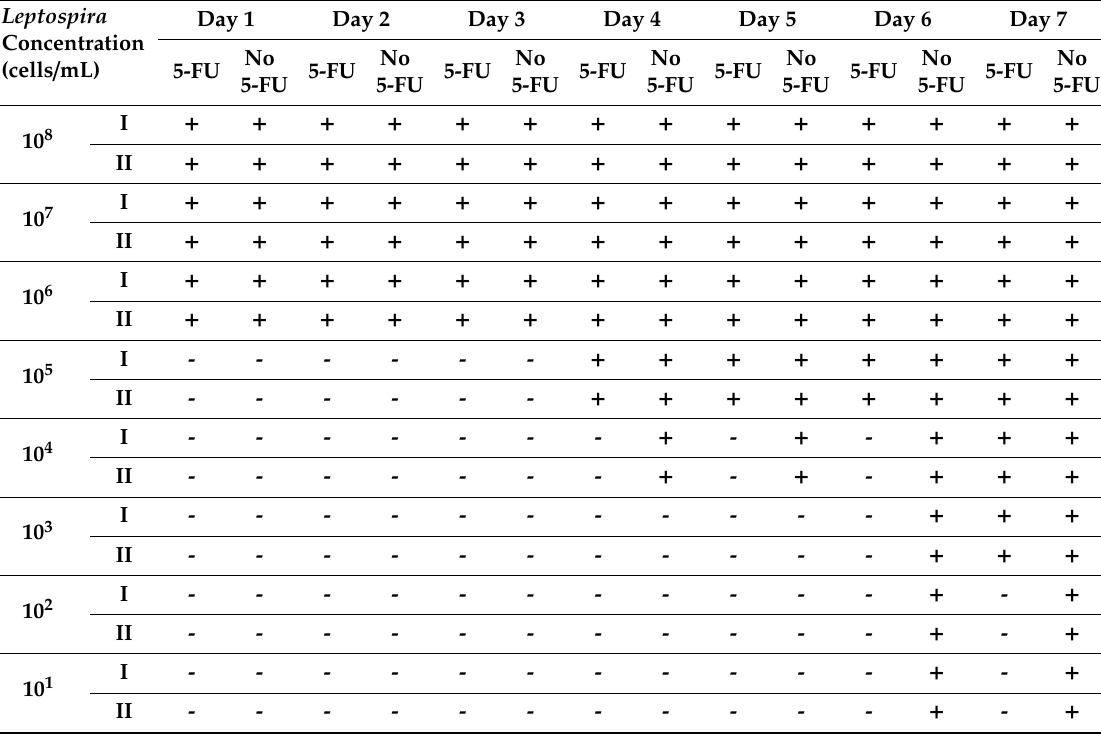
Table 3. Microscopic observation under dark-field microscope for culture of Leptospira